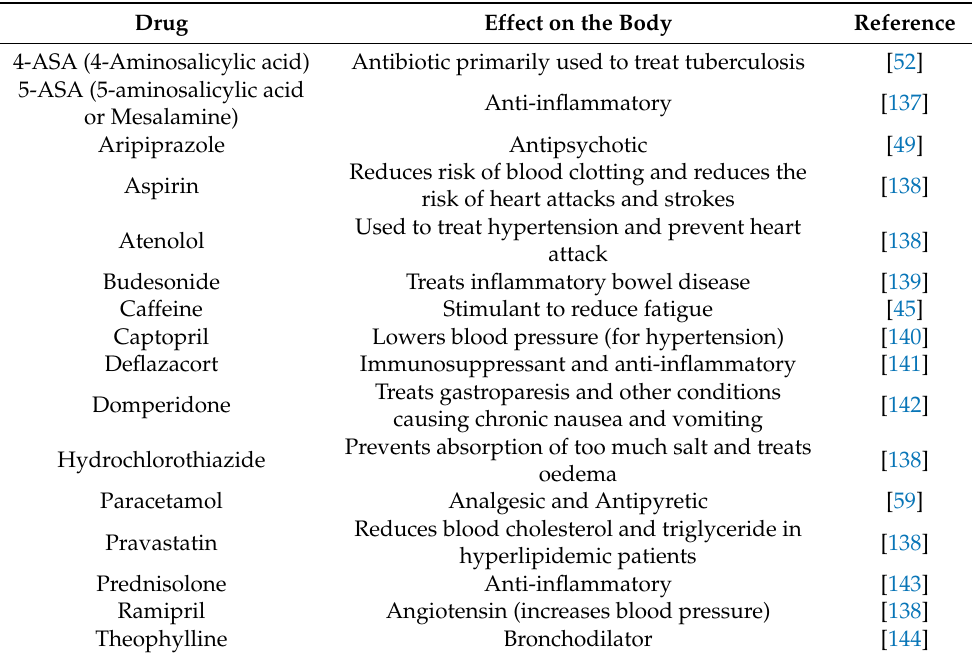
Table 1. Different active pharmaceutical ingredients (APIs) used to research 3D printing in the pharmaceutical industry and their effect on the